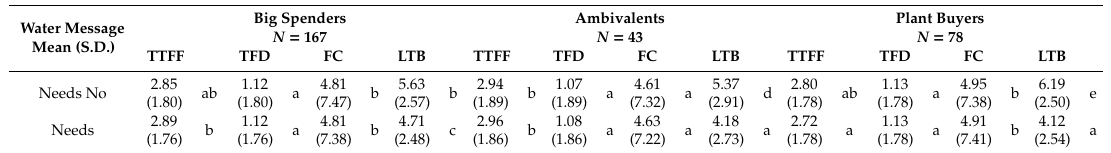
Table 7. Conjoint clusters eye-tracking for water messaging attributes 1